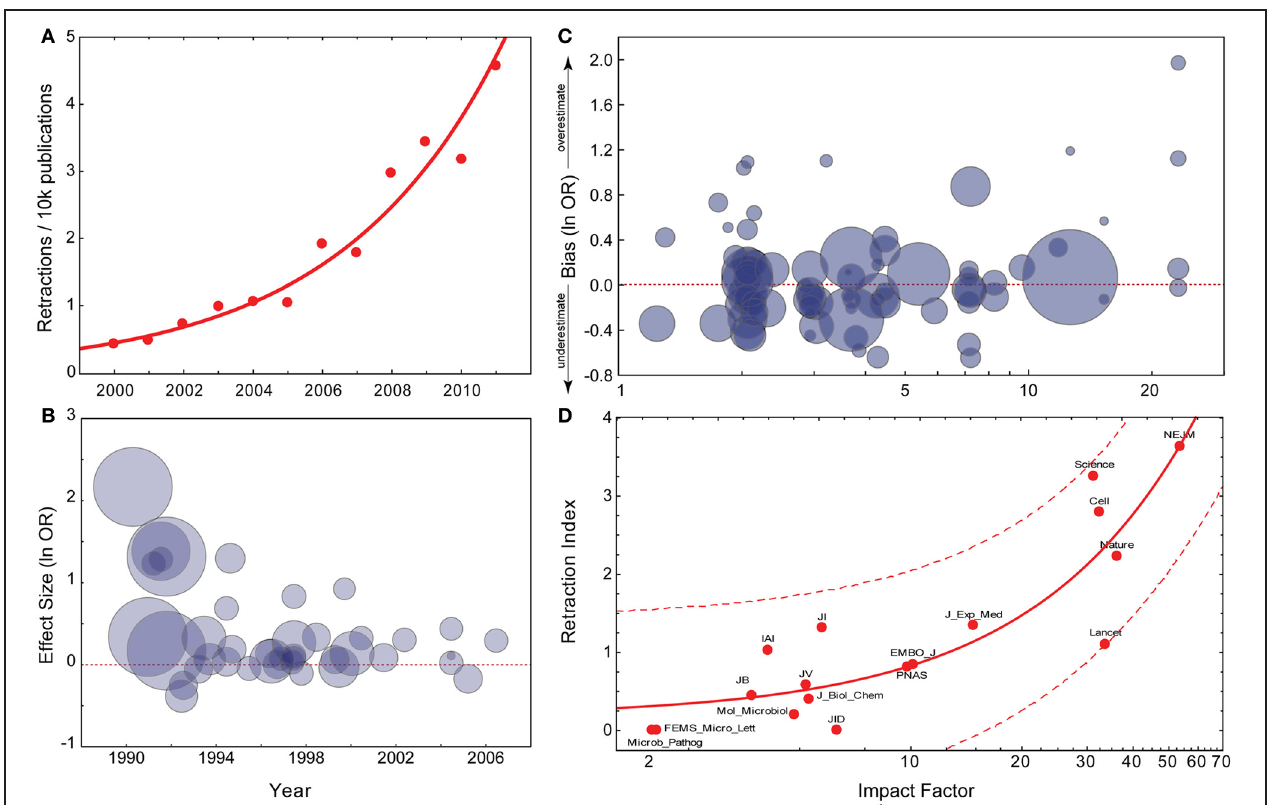
FIGURE 1 | Current trends in the reliability of science. (A) Exponential fit for PubMed retraction notices (data from pmretract.heroku.com). (B) Relationship between year of publication and individual study effect size. Data are taken from Munafò et al. (2007), and represent candidate gene studies of the association between DRD2 genotype and alcoholism. The effect size (y-axis) represents the individual study effect size (odds ratio; OR), on a log-scale. This is plotted against the year of publication of the study (x-axis). The size of the circle is proportional to the IF of the journal the individual study was published in. Effect size is significantly negatively correlated with year of publication. (C) Relationship between IF and extent to which an individual study overestimates the likely true effect. Data are taken